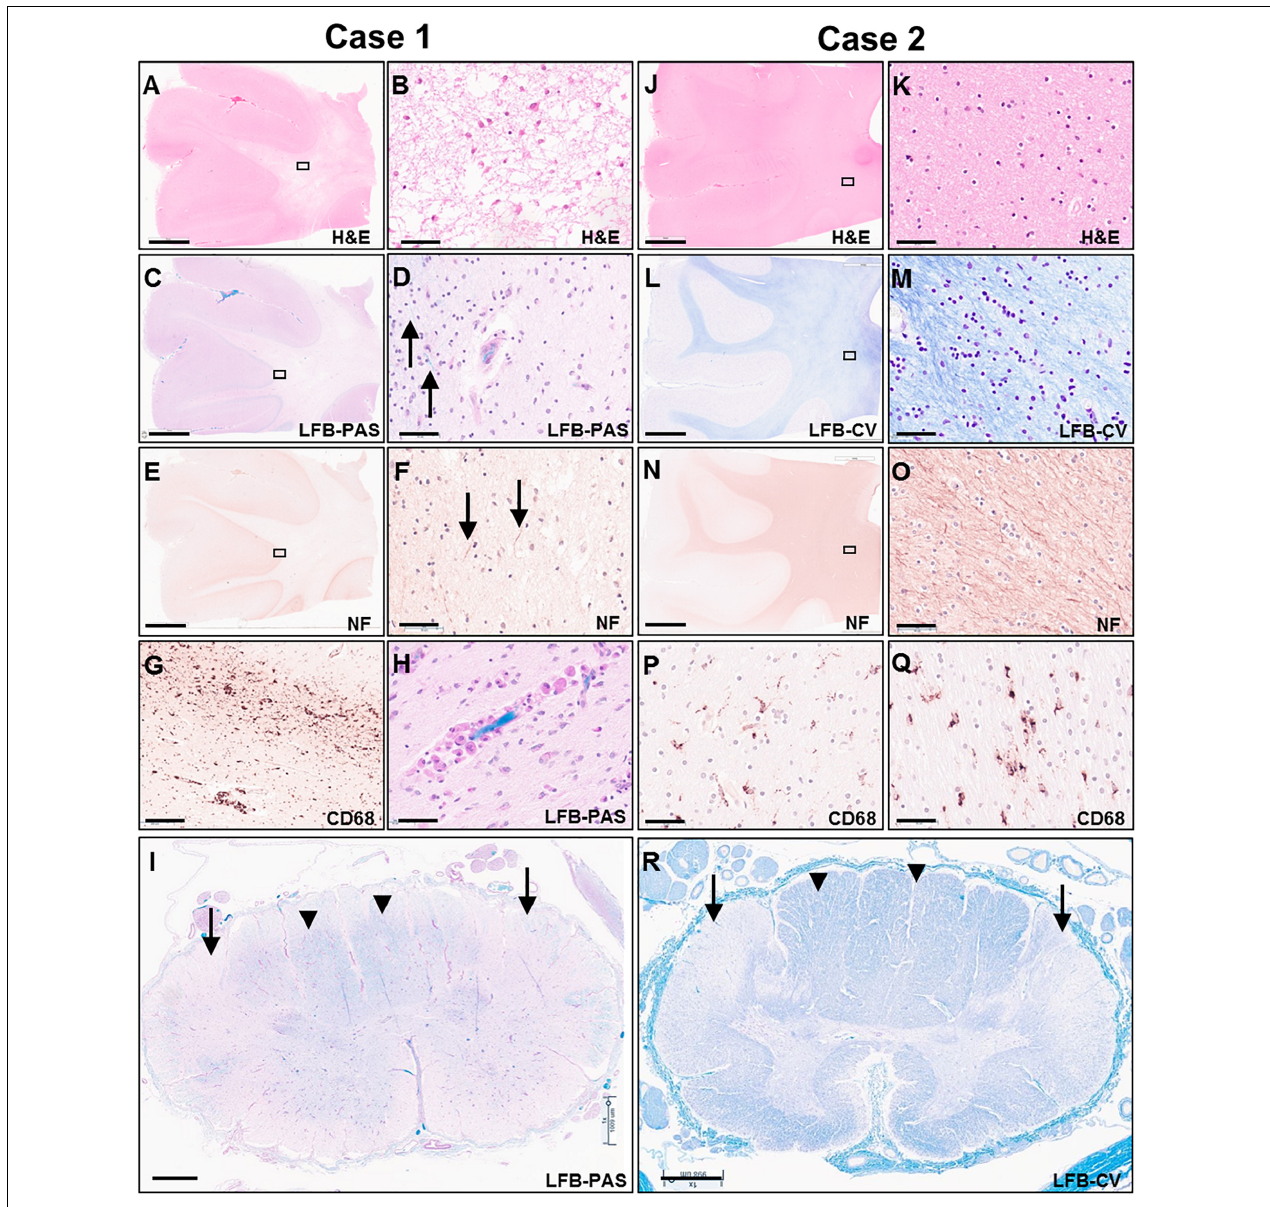
FIGURE 5 | Photomicrographs of representative H&E (A,B,J,K) , LFB-PAS (C,D,H,I) , LFB-CV (K,L,R) , neurofilament (E,F,N,O) and CD68 (G,P,Q) stained sections of the untreated case 1 (left two columns) and transplanted case 2 (right two columns). The rectangular boxes in the low power images indicate the region shown in the adjacent higher-power image. Images (A–H,J–Q) show frontal lobe (middle frontal gyrus) and images (I,R) demonstrate thoracic spinal cord. Arrows in images (D,F) indicate rare residual axons in case 1. Arrows in panels (I,R) point to the lateral corticospinal tracts, whereas arrow heads indicate posterior columns. Scale bars are set to 5 mm in panels (A,C,E,J,L,N) ; to 1 mm in panels (I,R) ; and to 50 µ m in panels (B,D,F,G,H,K,M,O,P,Q)